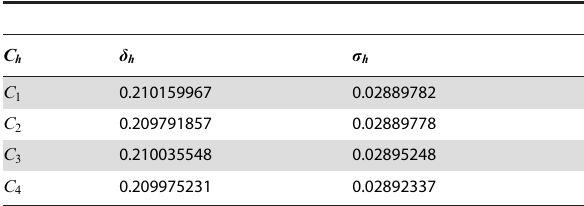
Table 1. Scenario 1A average within distance and relative standard deviation for communities simulated with b ~ 50 and a ~ 25 .